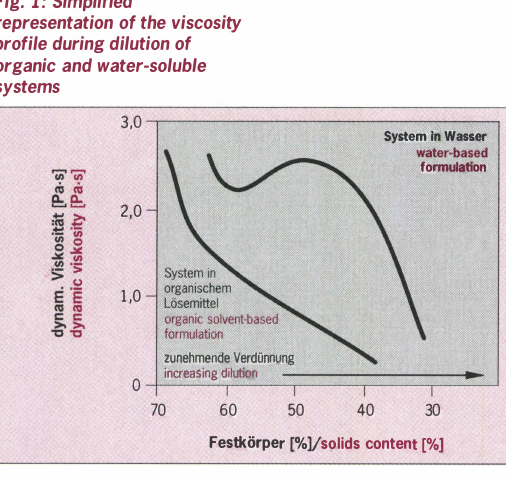
hydrophob hydrophobic NHR 3 ooc